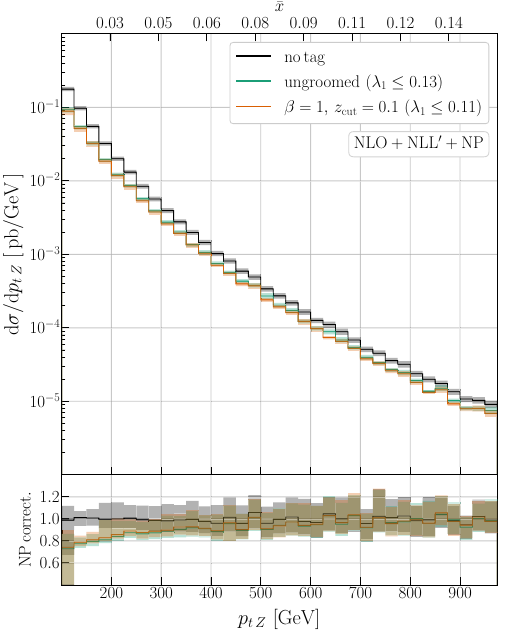
Fig. 3 Transverse momentum distribution of the Z boson in Z +jet events, with the leading jet tagged as quark-initiated, according to our operational definition, detailed in the text. The untagged distribution is also shown for comparison. The NLO+NLL (cid:7) calculation is supple- mented with a NP correction factor, shown at the